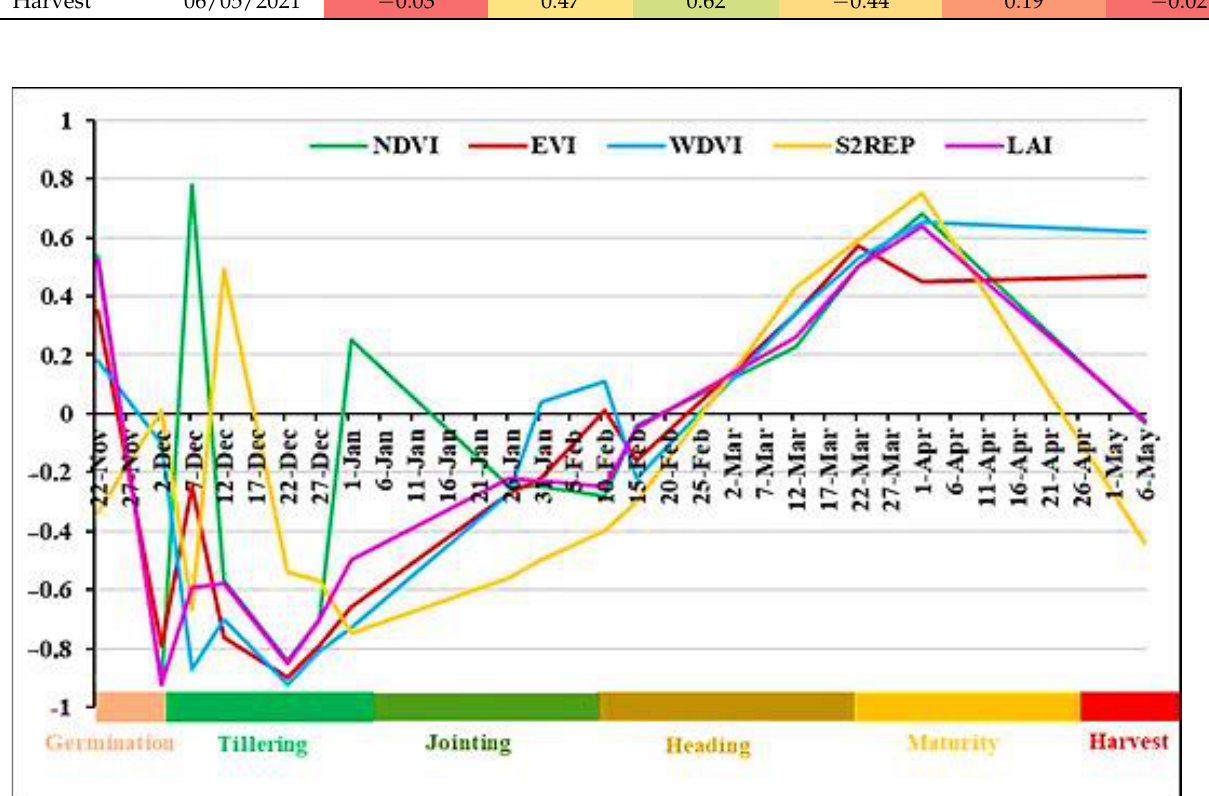
Figure 4. Correlations of remote sensing indices with in-situ yield. Durum wheat plant phenological stages.